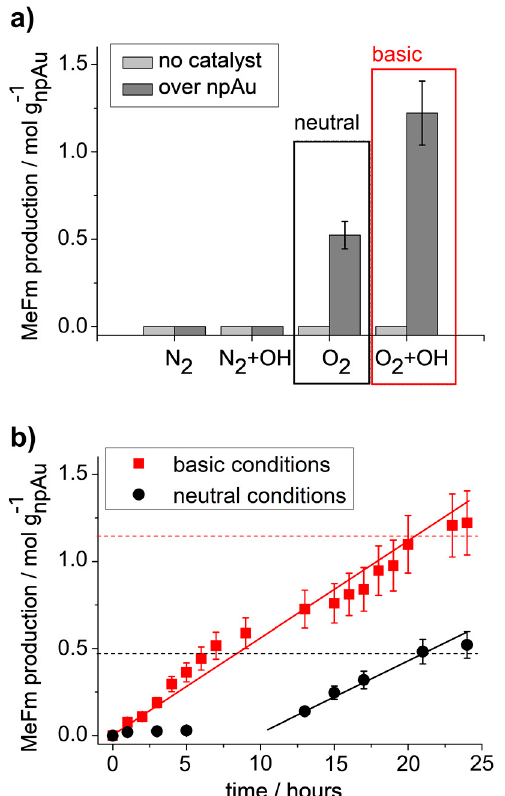
Figure 2. ( a ) Methyl formate (MeFm) production observed after 24 h at 60 ◦ C under di ff erent conditions: 3 bar N 2 , 3 bar N 2 , and 12 mM MOH added, 3 bar O 2 and 3 bar O 2 with 12 mM MOH added. All these four experiments were performed in presence as well as in the absence of npAu (1 at% residual Ag) as catalyst. ( b ) Methanol oxidation at 60 ◦ C and 3 bar O 2 as a function of reaction time: Comparison of the temporal evolution of MeFm formation under neutral as well as basic (12 mM MOH methanol) conditions.